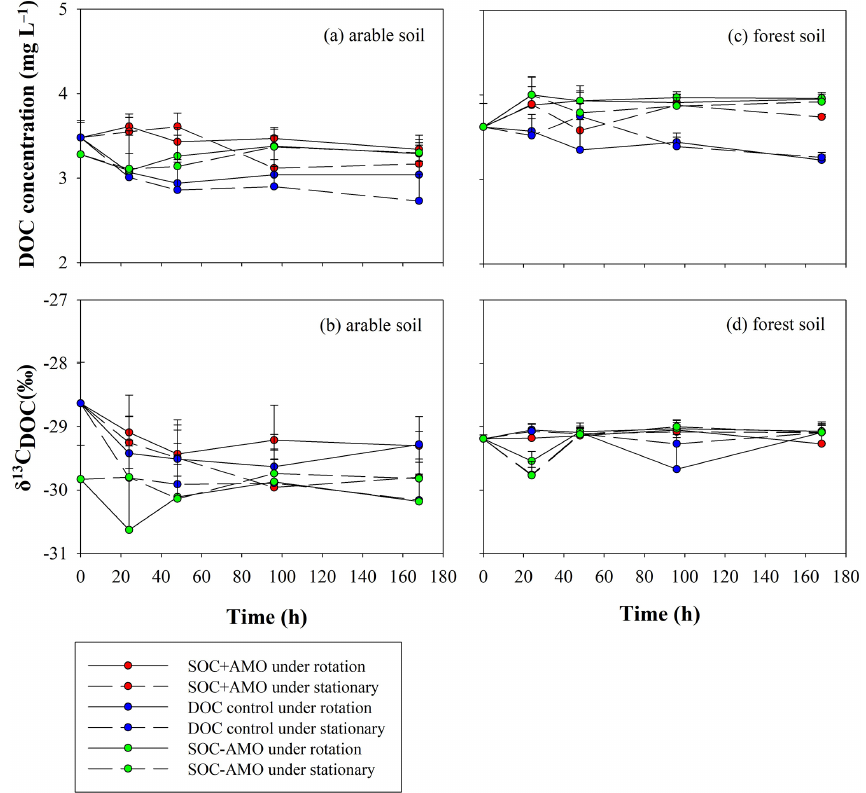
Figure 7. Evolution of DOC concentrations and δ 13 C DOC values during the incubations for the arable soil ( a, b , respectively) and the forest soil ( c, d ,